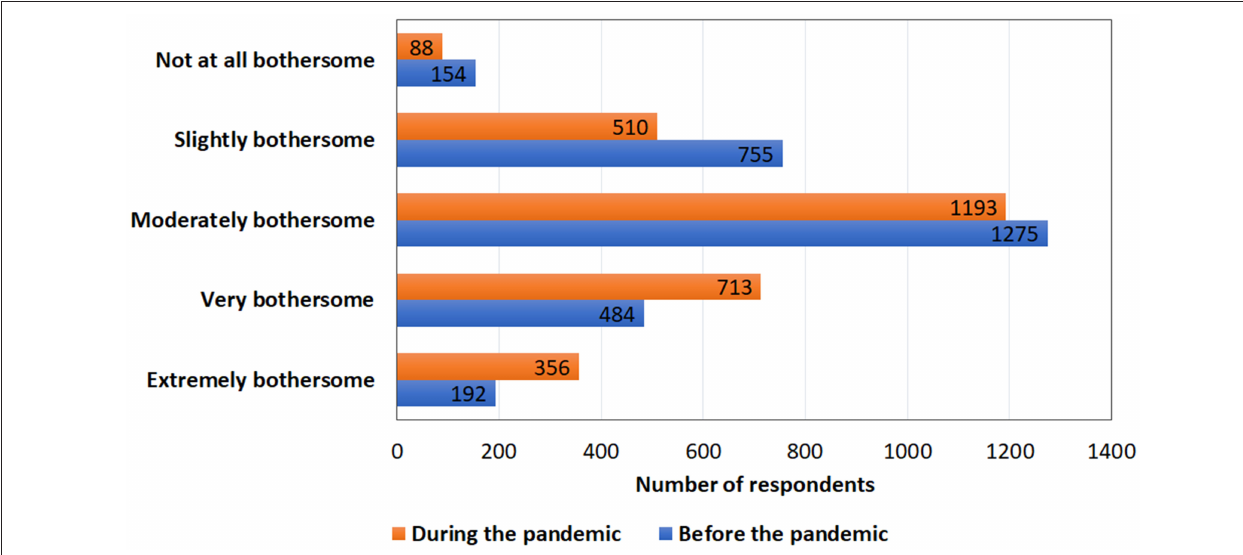
FIGURE 2 | Comparison of how bothersome tinnitus was before and after the COVID-19 pandemic.